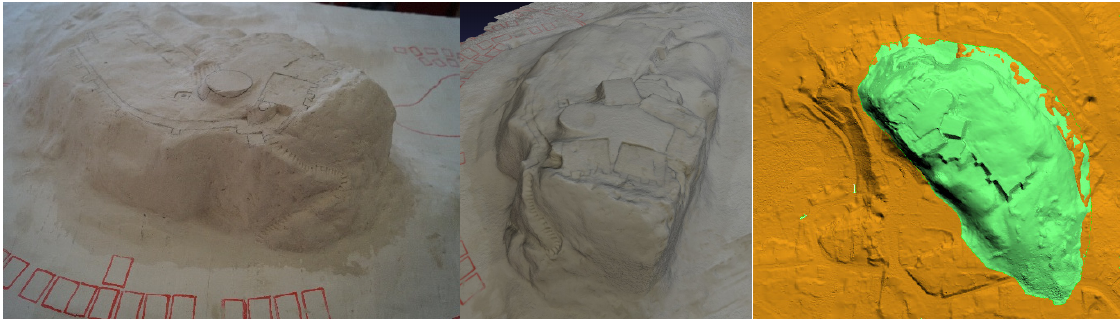
Figure 2. The reconstruction of the Kalkberg from airborne laser scanning data: digital elevation model (original data, left), printed scaled sections of the DEM (centre) and physical 3D model of the today existing Kalkberg (right)